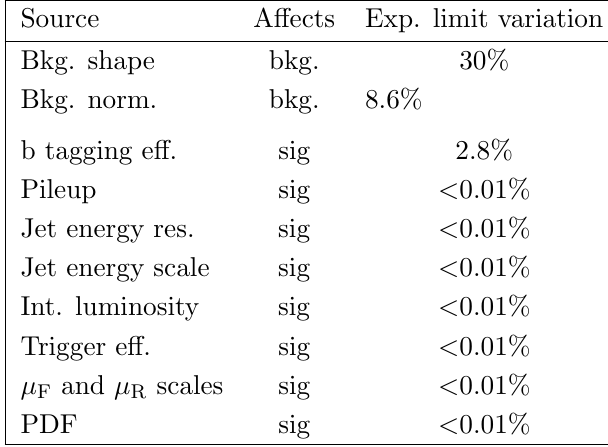
Table 4 . Systematic uncertainties considered in the analysis and relative impact on the expected limit for the SM HH production. The relative impact is obtained by (cid:12)xing the nuisance parameters corresponding to each source and recalculating the expected